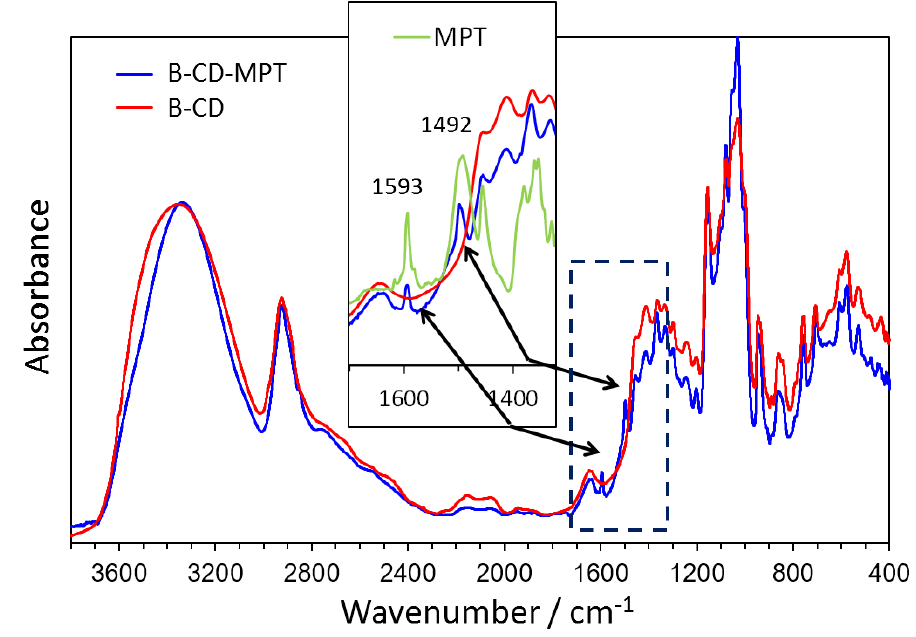
Figure 7. FTIR spectra of solid β -CD–MPT, MPT, and β